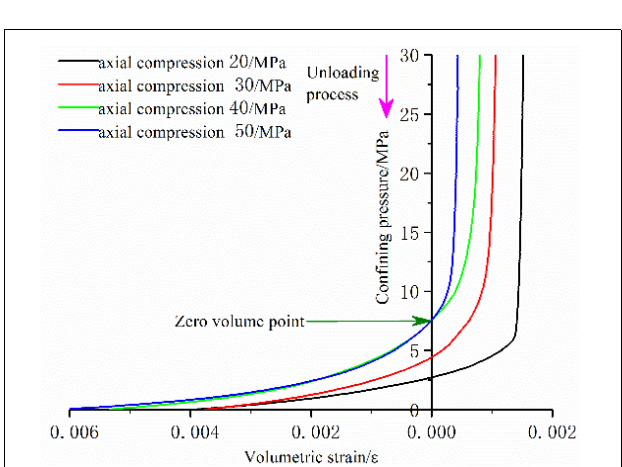
FIGURE 12 | Relationship between uniaxial peak intensity and initial axial